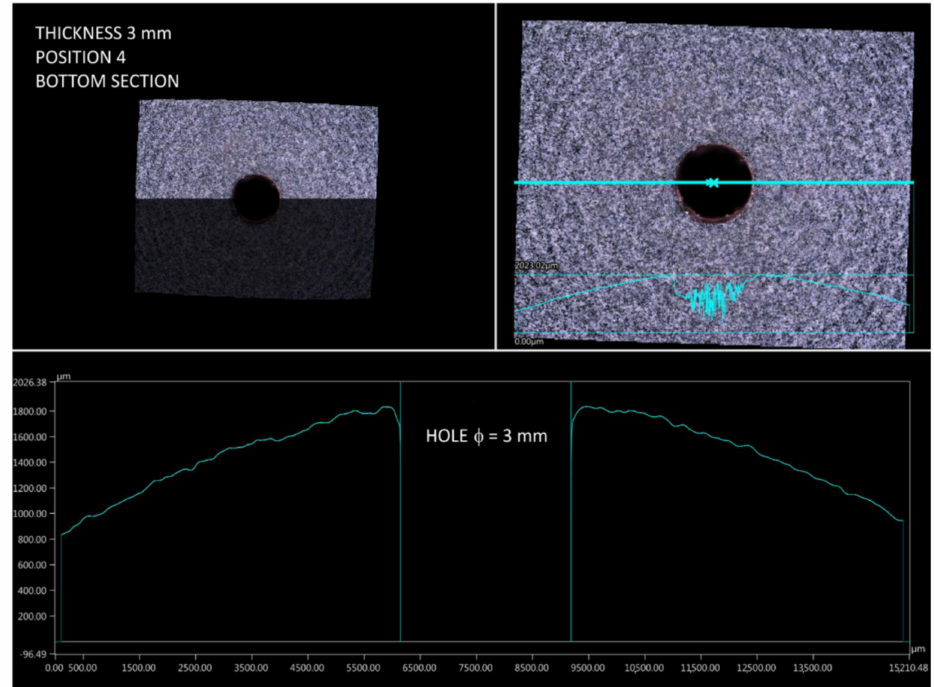
Figure 18. Surface profile of part 4.3 (bottom